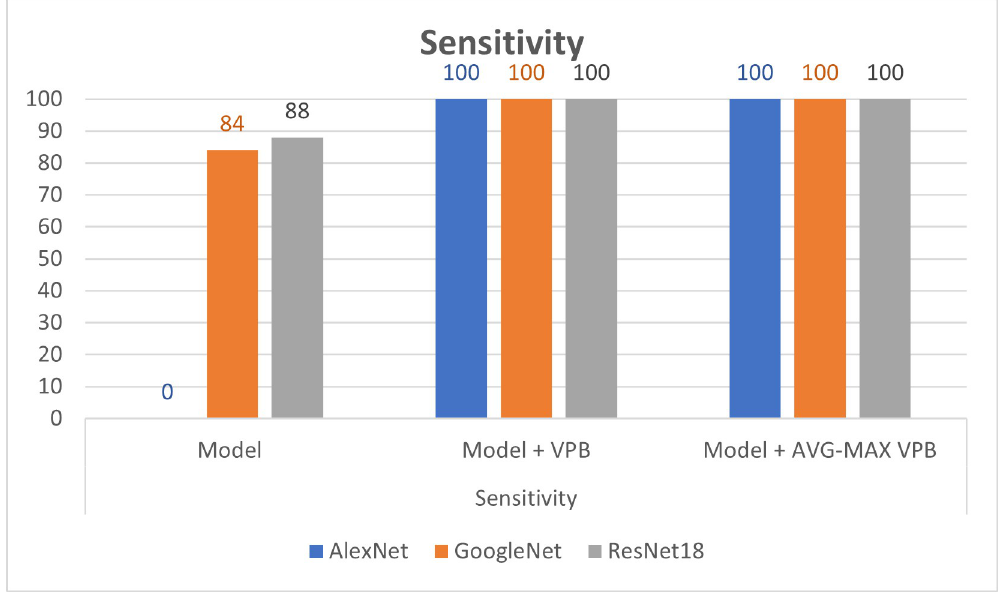
Fig 9. Illustrative chart for the sensitivity results for three CNNs before and after using VPB and AVG-MAX VPB presented in Table